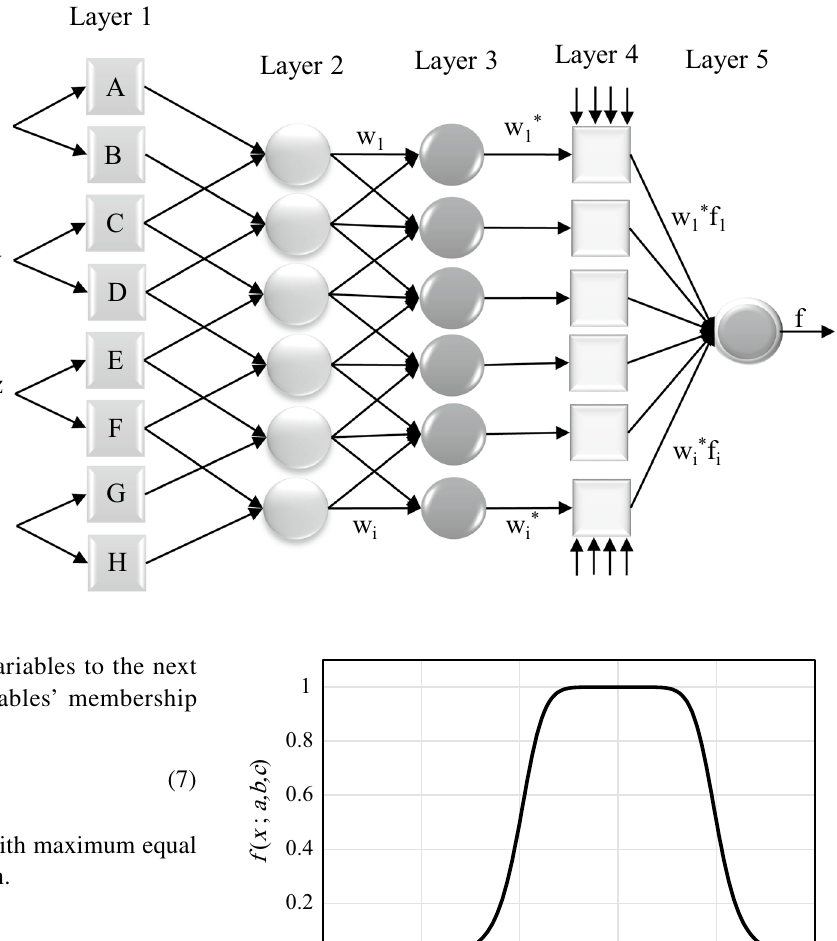
Fig. 5 ANFIS structure